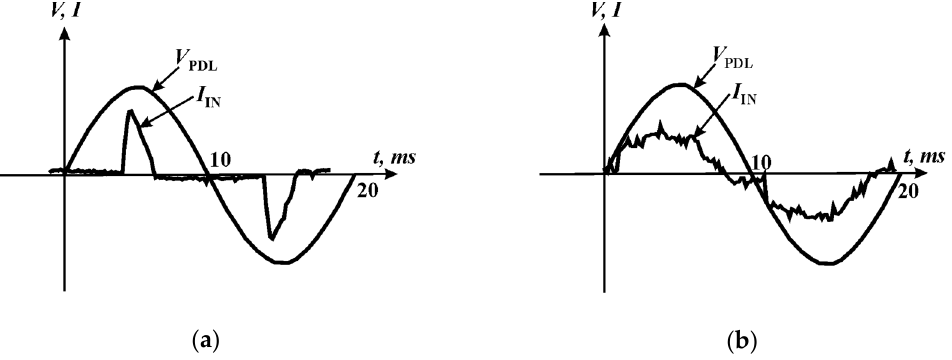
Figure 5. Voltage of the distribution line and input current of the LED power supplier: ( a ) conventional capacitive rectifier-based supply; ( b ) supply with the PFC correction function. Table 1. Measurement results for the conventional capacitive rectifier-based LED power supplier. Load, A